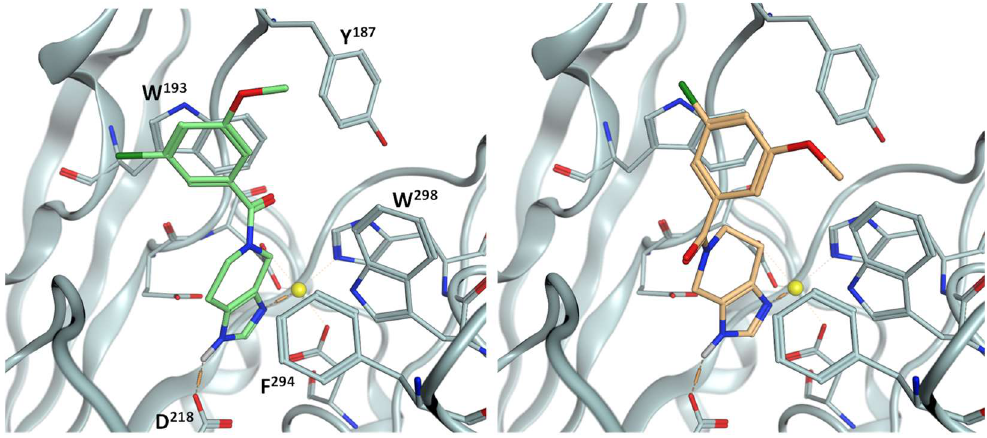
Figure 5. Putative binding mode of 8t . Docking with GOLD, pdb: 6QQL. Left: 5-yl tautomer, solution ranked 2/20; right: 6-yl tautomer, solution ranked 1/20.